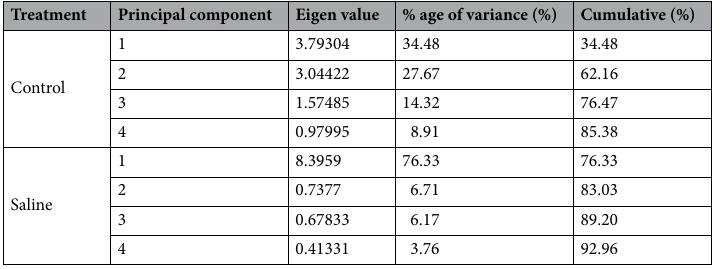
Table 1. The Eigen values of the first four components and their variability percentage under control and saline